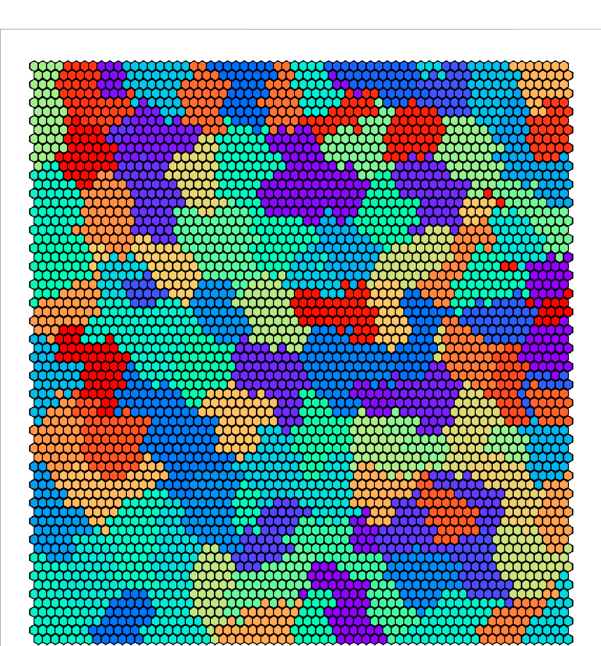
FIGURE 8 Graphical representation of the 100 clusters identi fi ed by the SOM on dataset D 2 . Each hexagon represents a neuron colored according to the cluster it belongs to, that is, the BC it